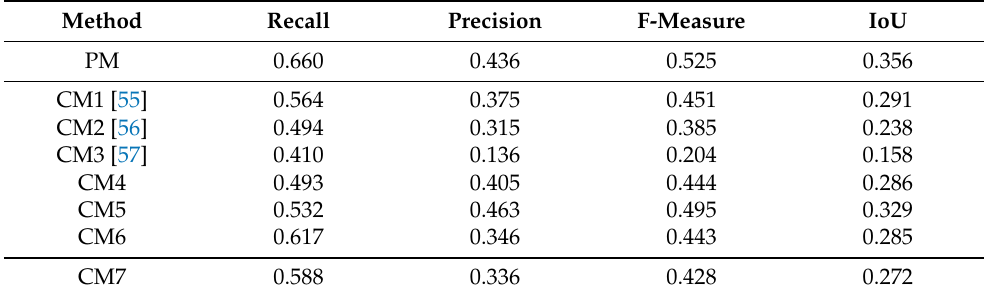
Table 3. Defect detection performance of the proposed method (PM) and the comparative meth- ods (CMs).